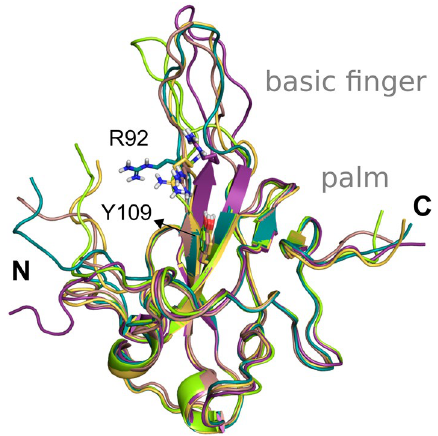
Figure 5. States from the NMR spectroscopy selected as the five representative structures of the N-NTD flexibility after clustering based on the conformations of Arg92 and Tyr109.